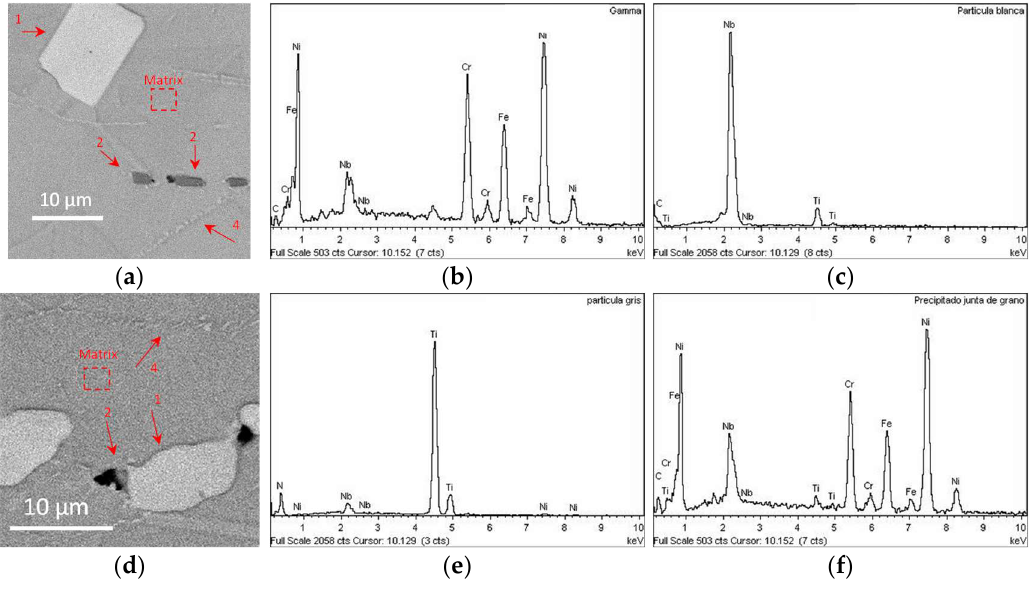
Figure 12. Substrate SEM analysis: ( a ) as-deposited sample; ( d ) direct-aged sample; ( b ) matrix EDS; ( c ) 1-white particle EDS; ( e ) 2-Grey particle EDS; ( f ) 4-grain boundaries EDS.